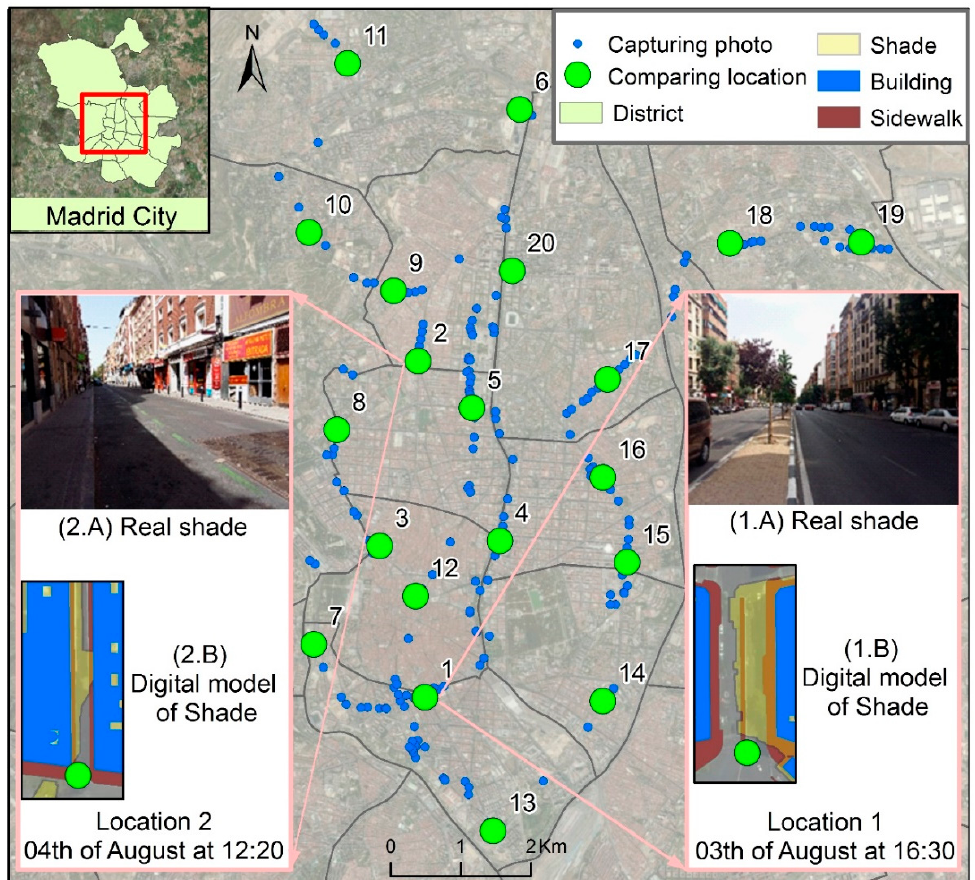
Figure A1. Map showing spots where actual sun/shade conditions (street photographs) have been contrasted with model outputs (blue and brown diagrams).